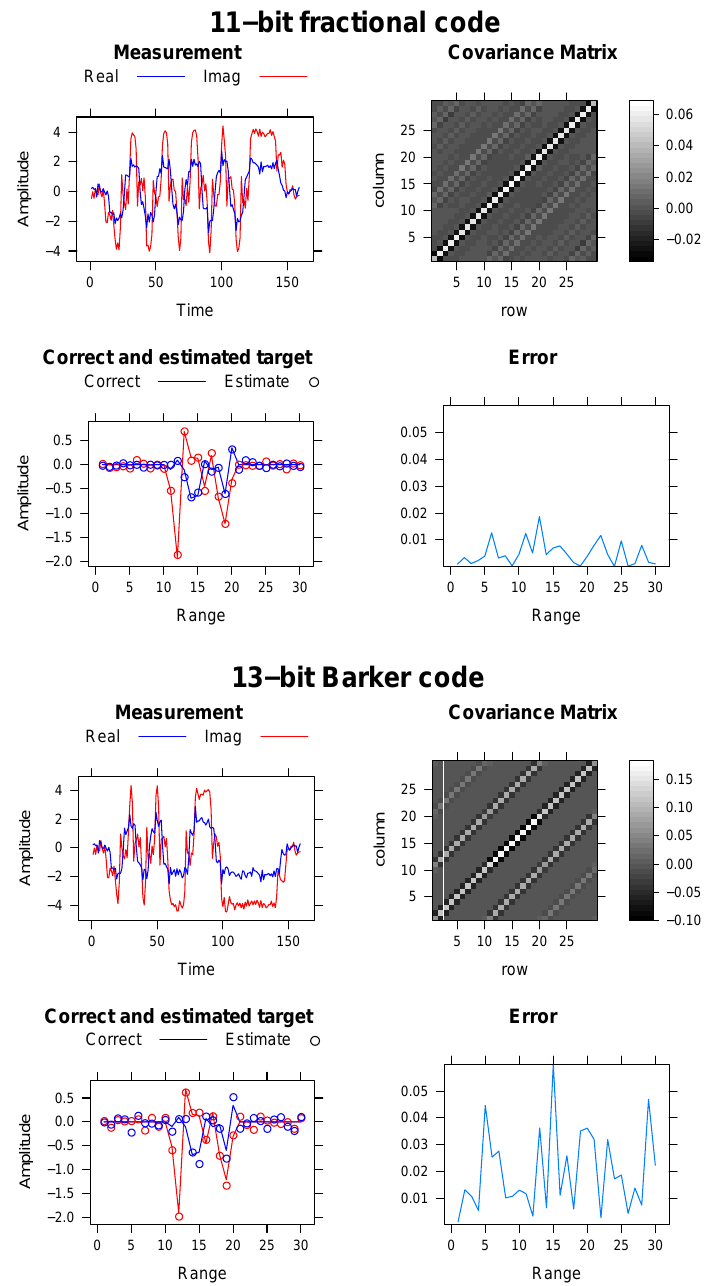
Fig. 4. Simulated coherent echo from a 11-bit non-uniform baud-length code that is 13µs long and the smallest baud-length is 1µs. When compared to the performance of a uniform baud-length 13-bit Barker code with 1µs baud length, the performance is again better. The simulated target length is 10µs and SNR = 3.